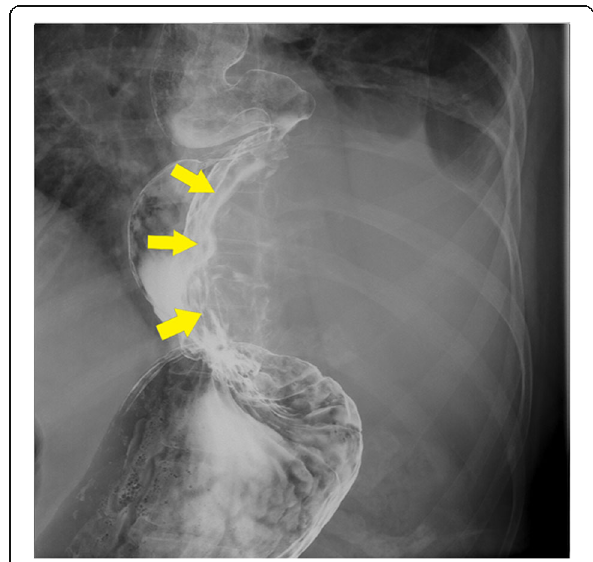
Fig. 1 Barium esophagogram showing a sliding esophageal hiatal hernia and defects of the lower esophagus and gastric wall caused by a huge tumor